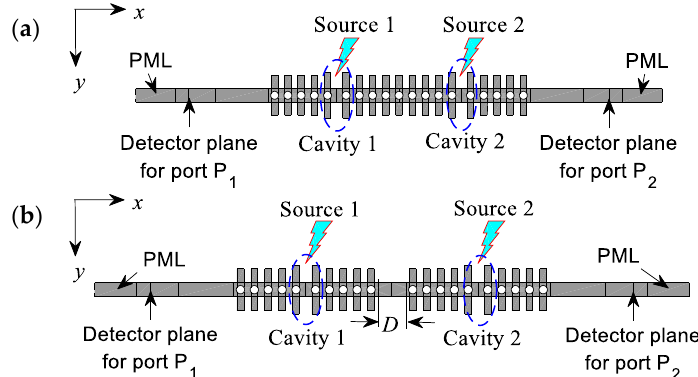
Figure 5. Schematic presentation of the phononic nanobeams including two connected defects with the schematic representation ( a ) shape A, “ − o 4 × o N × o 4 − ” and ( b ) shape B, “ − o 4 × o 4 − o 4 × o 4 − ”.